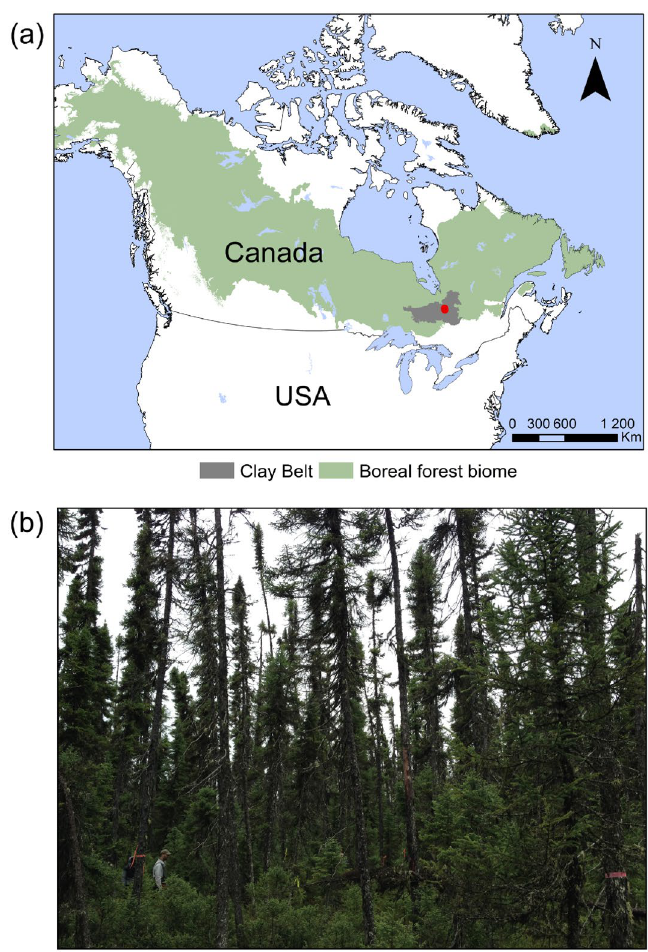
Figure 1. ( a ) Location of the studied boreal forested peatland (red dot) in the Clay Belt of eastern Canada (map generated using ArcGIS 10.7.1—https ://deskt op.arcgi s.com/). ( b ) Photograph of the sampling site